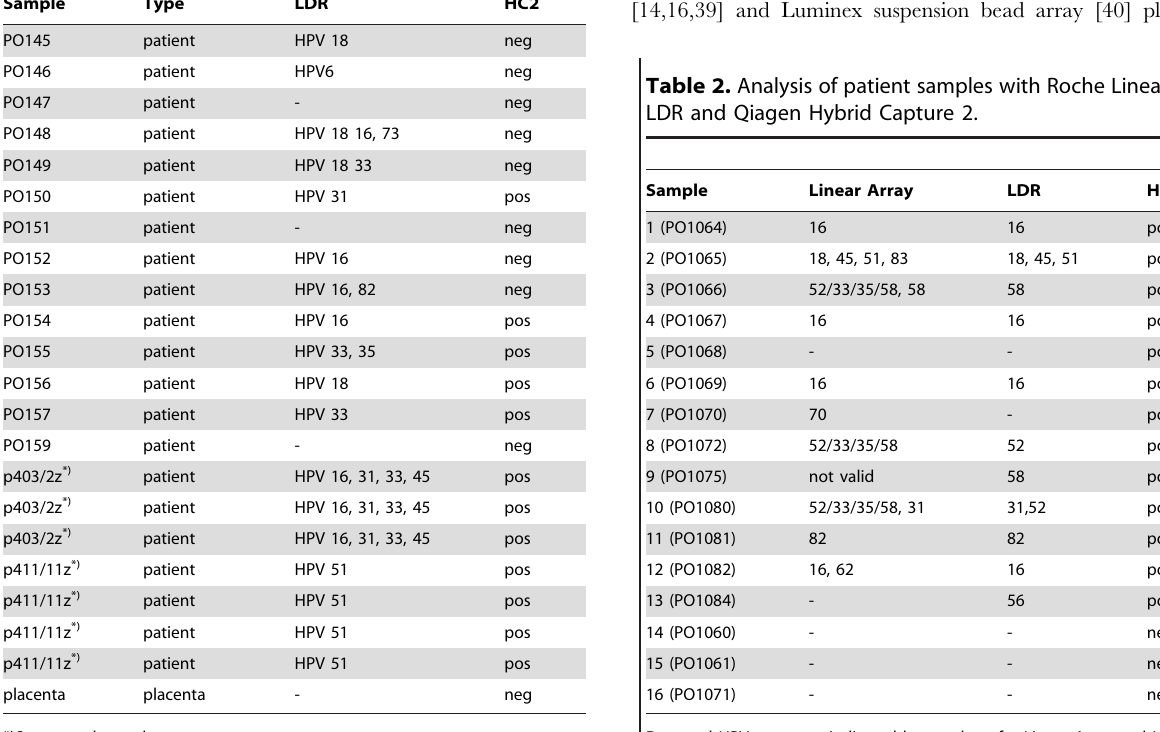
Detected HPV types are indicated by numbers for Linear Array and LDR.